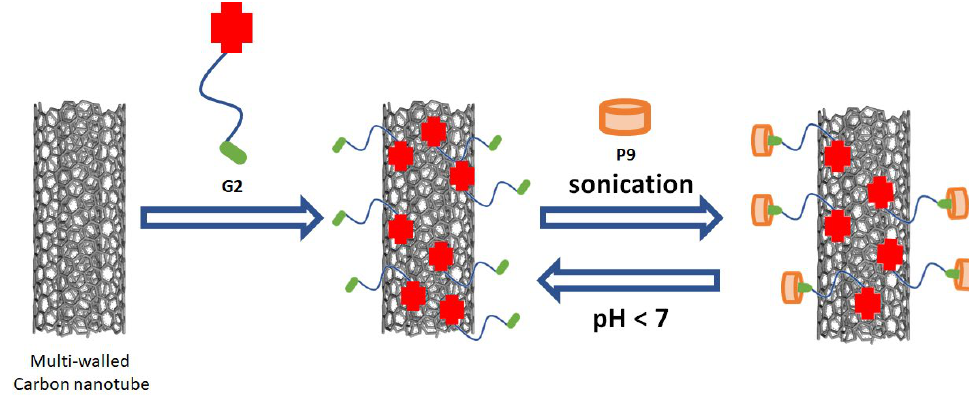
Figure 1. Illustration of dispersing multi-walled carbon nanotube by using amphiphilic host–guest inclusion P9 ⸧ G2 in aqueous solution [76].